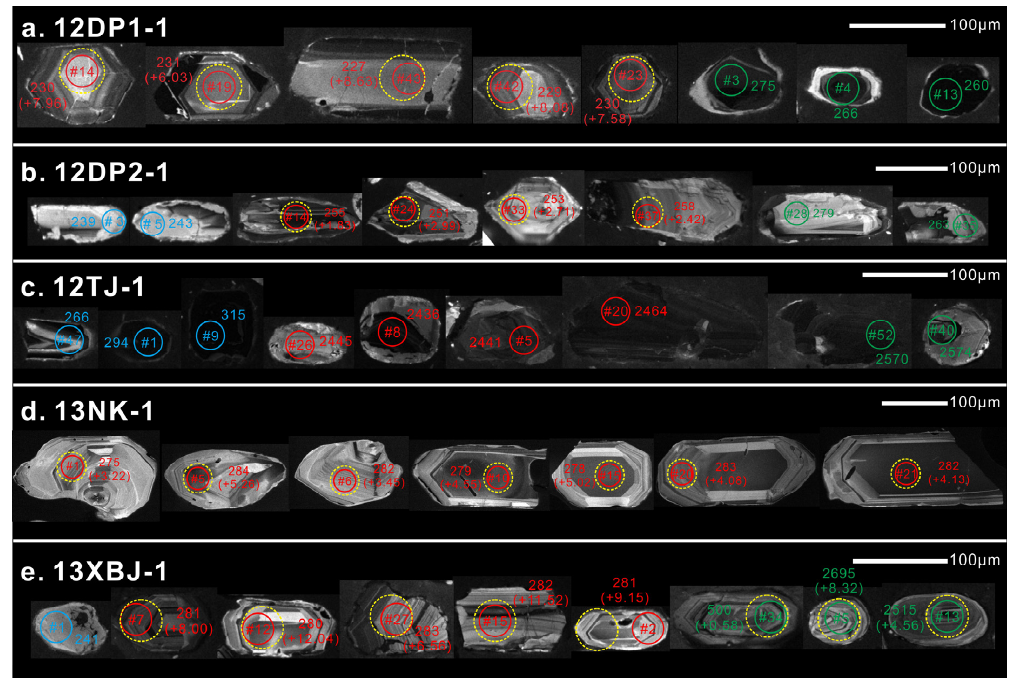
Figure 6. Representative cathodoluminescence (CL) images of zircons from the ( a , b ) gneisses, ( c ) actinolite schist, ( d ) leptynite and ( e ) hornblende ‐ biotite schist in this study. The solid ‐ line and dash ‐ line circles represent the locations for U ‐ Pb dating and in situ Lu ‐ Hf isotope analysis, respectively. The numbers show the ages of the zircons (Ma) and the ε Hf (t) values. Zircons from sample 12DP2 ‐ 1 are yellowish pink, translucent to transparent, and subhedral, and show oval (e.g., # 5) to long prismatic shape. Crystal lengths are approximately 50 to 300 μ m, with aspect ratios of 1:1 to 3.5:1. There are mainly two types of zircon with complex internal structures as revealed by CL imaging (Figure 6b): (1) some zircons show oscillatory, blurred oscillatory or planar zoning without core ‐ rim structure, which are interpreted as magmatic origin but suffered low degrees of metamorphic recrystallization (e.g., # 5); (2) the others exhibit core ‐ rim structure and core ‐ rim boundaries are generally irregular. The cores are characterized by oscillatory, cloudy, weak zoned, or unzoned structures, indicating that they are magmatic origin but reworked by varying degrees of recrystallization. Most of the rims cut the primary zones of cores, indicating of metamorphic recrystallization. Rare rims and cores have regular boundaries (e.g., # 24), which are interpreted to be metamorphic growth.